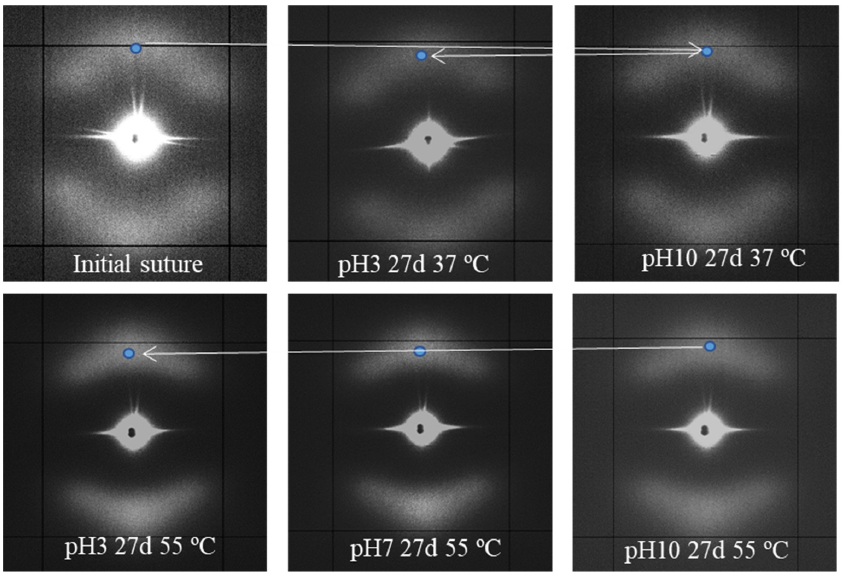
Figure 10. SAXS patterns of the initial suture and those exposed to the indicated hydrolytic conditions.